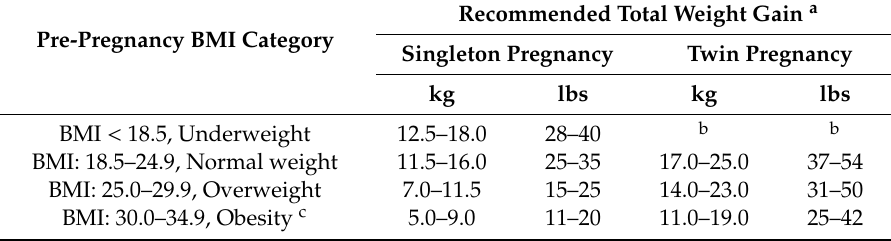
Table 1. Gestational weight gain